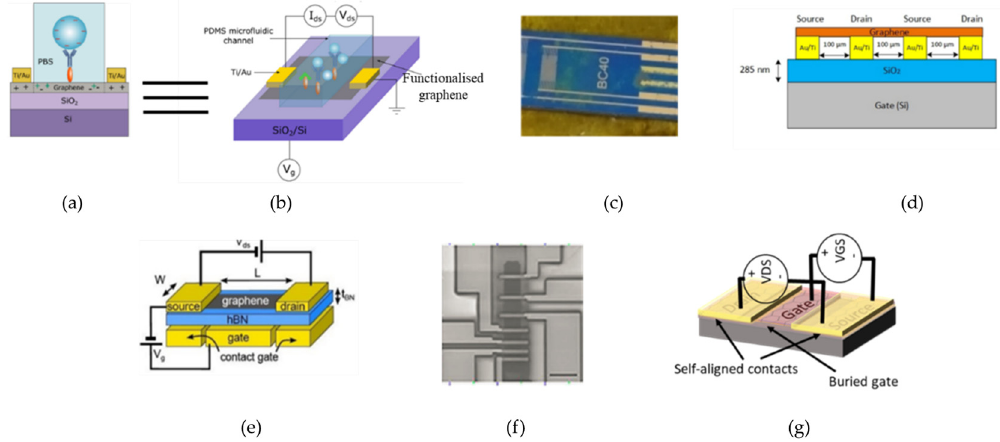
Figure 3. Back-gated graphene transistors: ( a ) graphene FET biosensor for the label-free sensing of exosomes [25]; ( b ) topology of the biosensor; ( c ) graphene photodetector [28]; and ( d ) the topology of the photodetector; ( e ) graphene FET used for the study of the saturation velocity with h-BN as a gate dielectric [29]; ( f ) graphene photodetector [30]; and ( g ) the topology of ( f ).